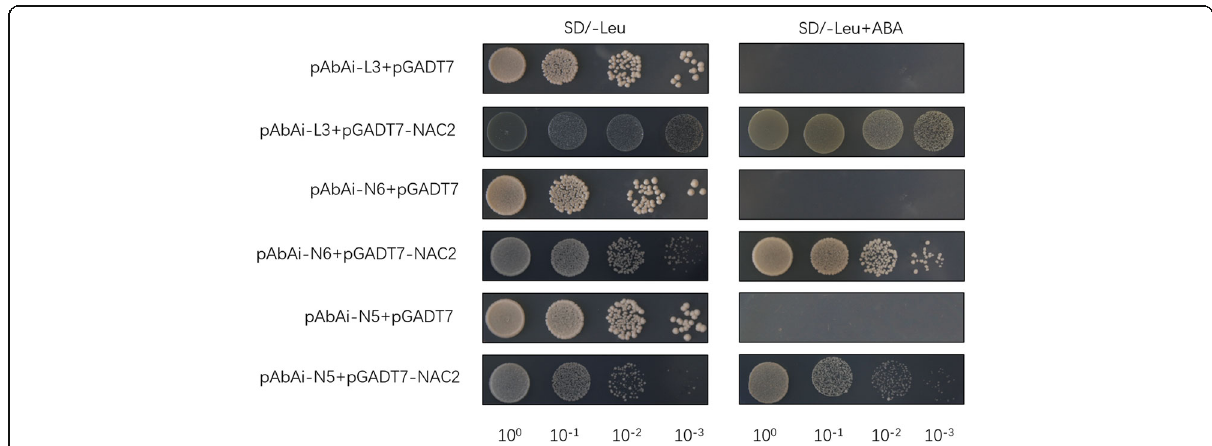
Fig. 7 OsLEA3 and OsNCED3 are direct target genes of OsNAC2. The full-length OsNAC2 cDNA was fused to the GLA4 activation domain in the prey vector. The promoter sequence regions of different lengths were fused to an AbAi reporter gene in the bait vector. For yeast one-hybrid assay, Yeast cells were cotransformed with a bait vector and a prey vector and grown in liquid medium and diluted in a 10× dilution series (from 10 0 to 10 − 3 ). Each dilution was spotted on both SD/ − leu and SD/ − leu with 300 ng/ml AbA to suppress the background and to test the strength of the interaction. L3, partial OsLEA3 promoter sequence; N6 and N5, partial OsNCED3 promoter